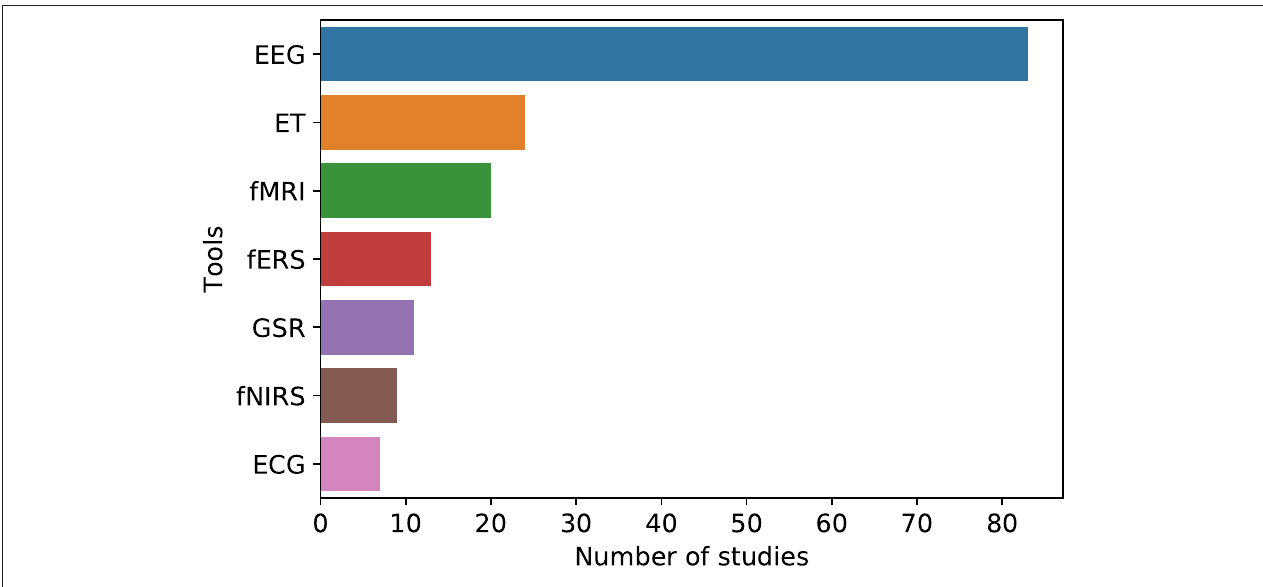
FIGURE 3 | An overview of neuroscience tools used in consumer neuroscience